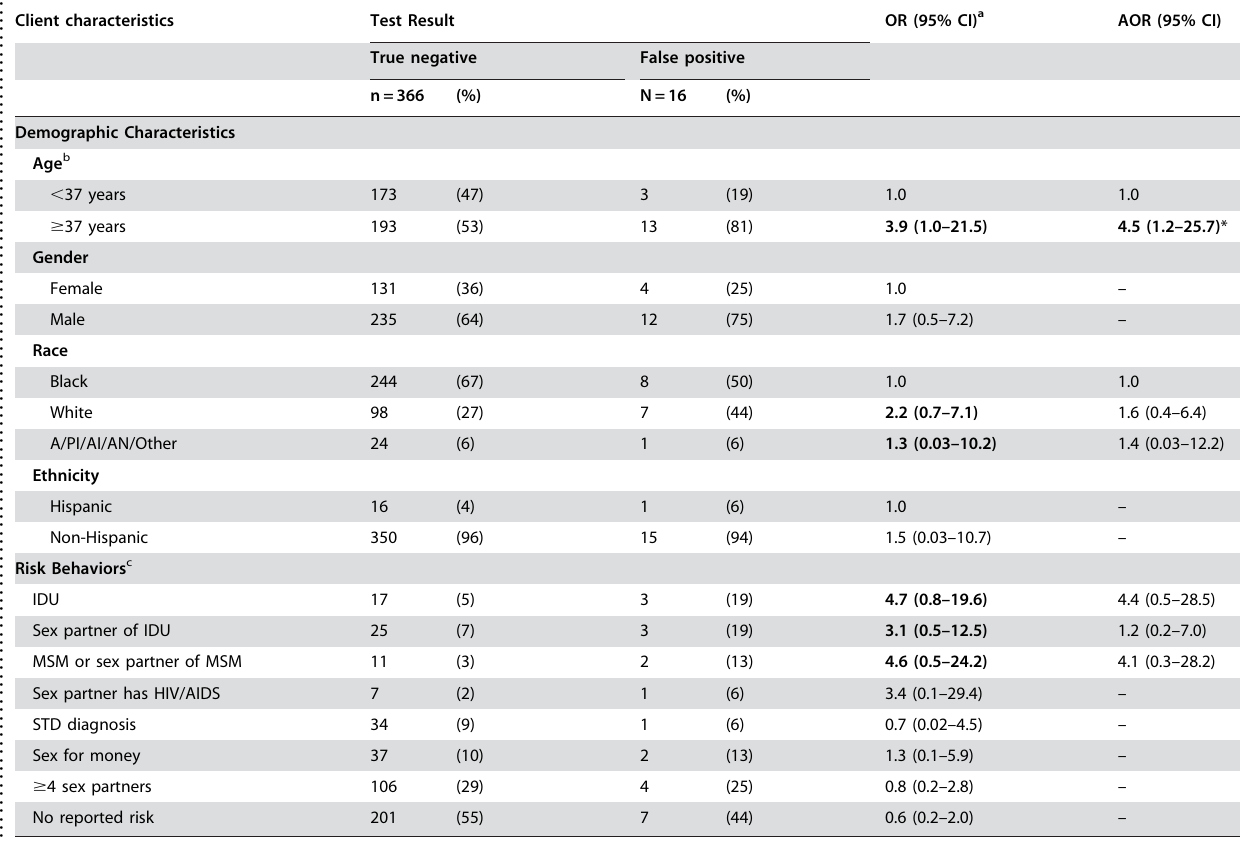
Table 1. Demographic and risk characteristics of 382 clients who had a true-negative or false-positive oral fluid OraQuick Rapid HIV-1 Antibody Test result—University of Minnesota performance study, April 15, 2004 through August 31, 2004. .. ... .... ... ... .... ... ... .... ... ... .... ... ... .... ... ... .... ... ... .... ... ... .... ... ... .... ... ... .... ... ... .... ... ... .... ... ... .... ... ... .... ... ...